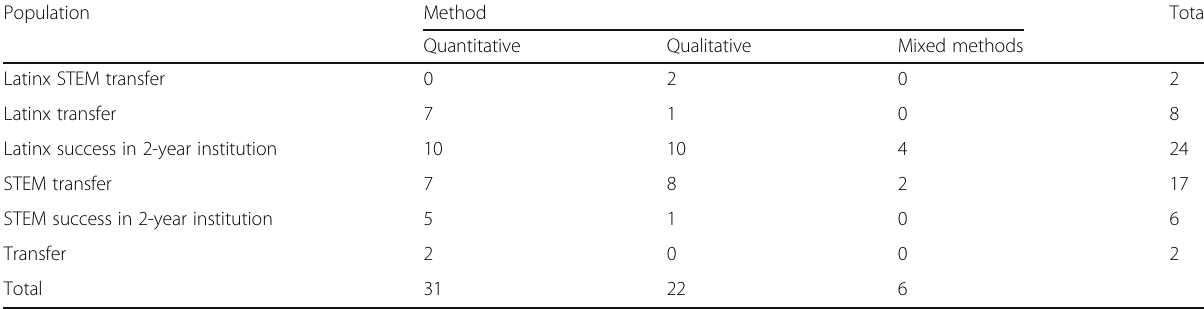
Table 2 Summary of all study populations